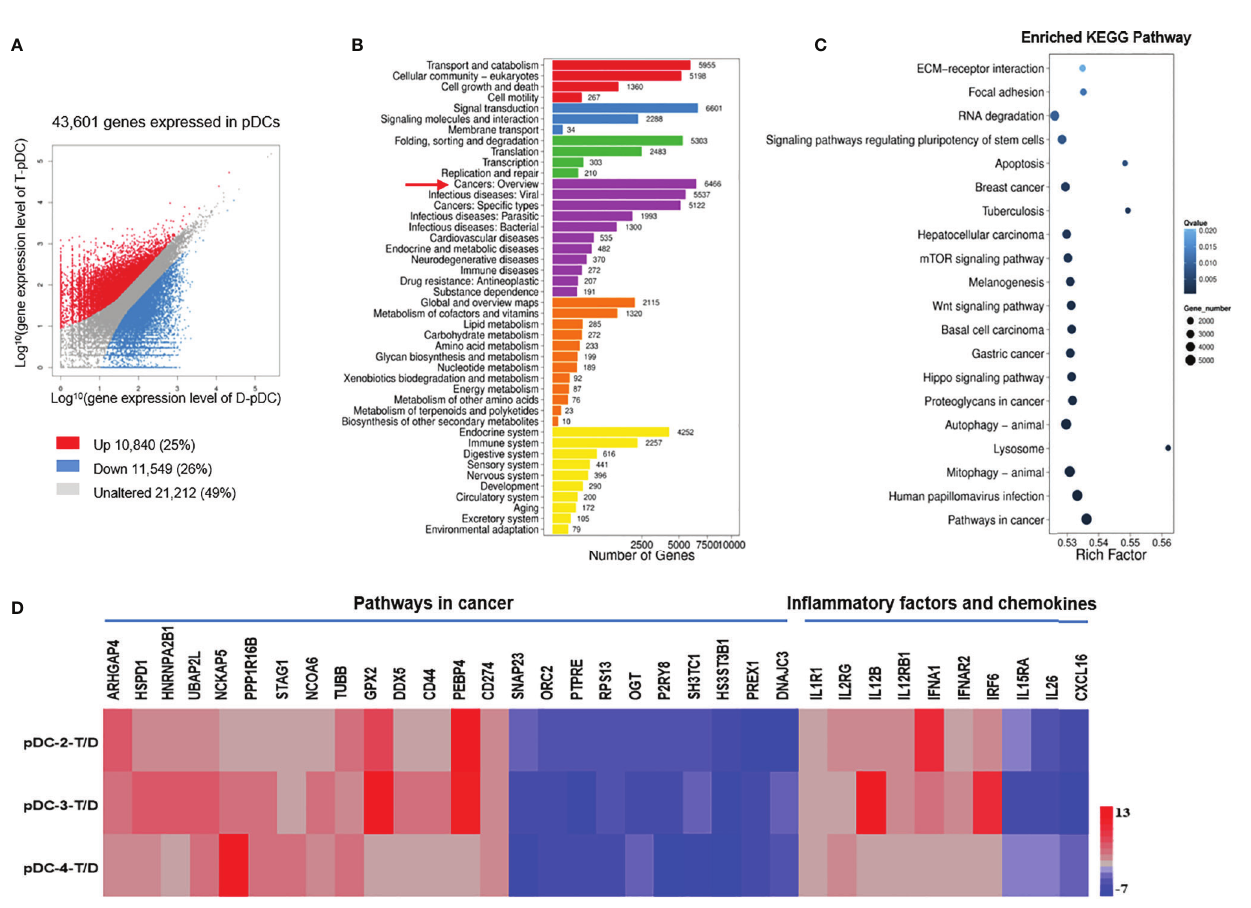
FIGURE 4 | DEGs in pDCs are associated with tumor development. Analysis of gene expression in tumor and distal pDCs and identi fi cation of signi fi cant pathways regulated by the DEGs. (A) Scatter plot of DEGs: X and Y axes represent log 10 -transformed gene expression levels. Upregulated, downregulated, and unchanged genes are presented in red, blue, and gray, respectively. (B) Pathways regulated by the DEGs: The X-axis represents the number of DEGs, whereas the Y-axis indicates the functional classi fi cation. (C) Pathway functional enrichment of DEGs: The X-axis represents the enrichment factor and the Y-axis signi fi es the pathway name. The color indicates the q-value (high: white; low: blue). A lower q-value represents a more signi fi cant enrichment. Point size indicates DEG number. Rich Factor refers to the value of the enrichment factor, which is the quotient of the foreground value (the number of DEGs) and the background value (total number of genes). The larger the value, the more signi fi cant the enrichment. (D) RNA-Seq analysis of DEGs in tumor versus distal pDCs. Data from three separate tumor pDCs (T, experimental group) versus data from three separate distal pDCs (D, control group). Many of the DEGs in pDCs were associated with tumor development and